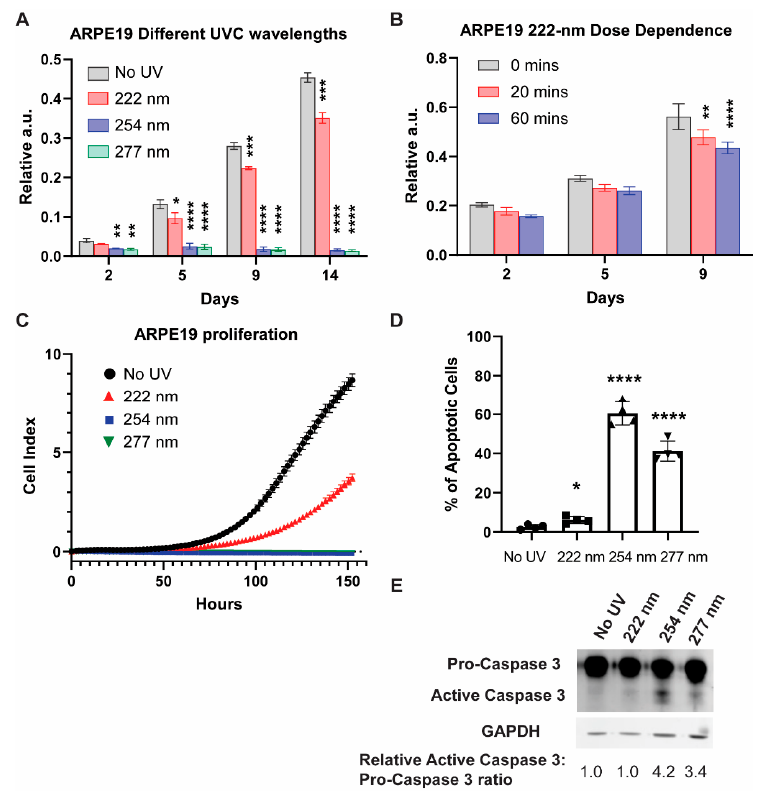
Figure 1. 254-nanometer and 277-nanometer UVC sources result in cell death driven by apoptosis, while 222-nanometer far UVC results in decreased cell viability compared to control. ( A ) SRB assay for ARPE-19 cells exposed to either no UVC or 60 min of respective UVC wavelengths and then incubated for the indicated number of days. Values are reported as mean +/ − S.D. from n = 3 experiments. ( B ) SRB assay for ARPE-19 cells exposed to either 0, 20 or 60 min of 222-nanometer far UVC and then incubated for the indicated number of days. Values are reported as mean +/ − S.D. from n = 3 experiments. ( C ) Dynamic monitoring of cell numbers through xCelligence platform. Values are reported as mean +/ − SD from n = 8 replicates. ( D ) Trypan blue staining assay performed on ARPE-19 cells exposed to either no UVC or 60 min of respective UVC wavelengths and then incubated for 1 day. Values are reported as mean +/ − SD from n = 4 experiments. ( E ) Representative Western blot analysis of pro-caspase 3 versus cleaved caspase 3 after either no UVC or 60 min of respective UVC wavelengths. GAPDH immunob- lotting was used as an internal control. Where applicable, Student’s t -test is performed and signifi- cance is represented as * p < 0.05, ** p < 0.01, *** p < 0.001, and **** p < 0.0001. To gain a comprehensive understanding of the cellular growth profile, we utilized the xCELLigence platform to track the dynamic changes in cell viability per condition. In agreement with the results from the SRB assays, the 222-nanometer UVC resulted in a significant reduction in cell numbers, while the 254-nanometer and 277-nanometer UVC saw no viable cell growth within the 6-day experimental period (Figure 1C). The 222-na- nometer-induced reduction in cell viability was dose-dependent, as demonstrated in Fig- ure S1.